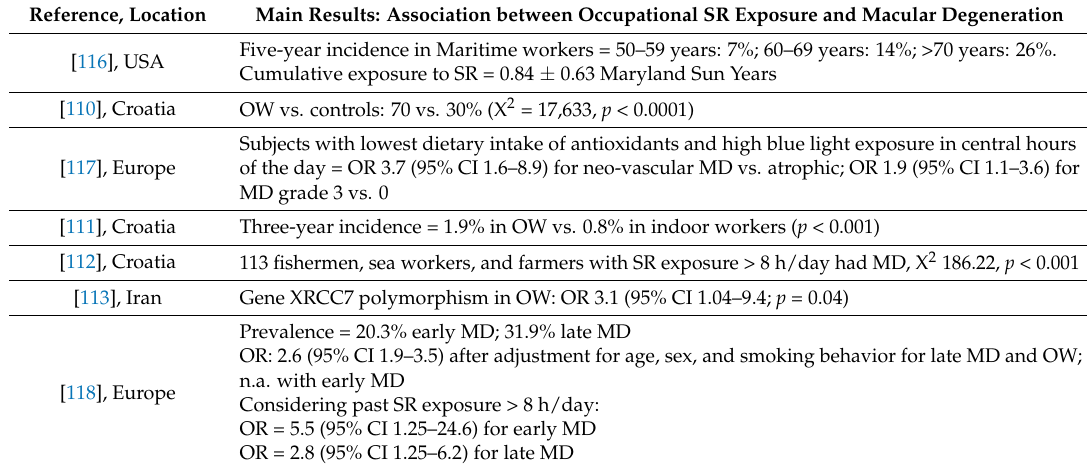
Table 6. Macular degeneration (MD) prevalence and mean ORs calculated in scientific studies conducted in OW (adapted from Modenese and Gobba, 2018